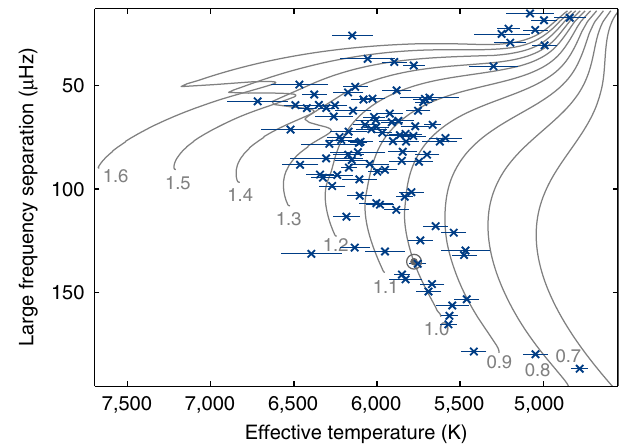
Figure 1 | The seismic host stars. Asteroseismic Hertzsprung–Russell diagram showing the large frequency separation as a function of stellar effective temperature (with 1 s uncertainties) for the 102 exoplanet host stars in the asteroseismic sample. The grey lines show evolution tracks of different masses (in solar units) for solar composition (adapted from ref. 41). The location of the Sun is indicated by the grey solar symbol (circle with a